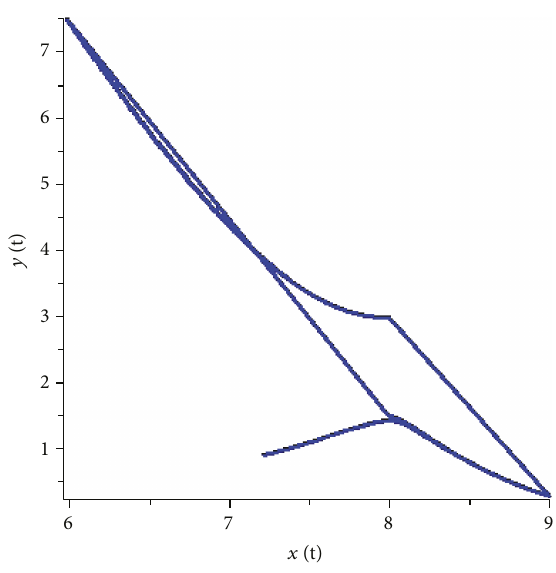
Figure 17: There exists an order-2 periodic solution in system (16) with q 1 = 1/9 , p = 0 8 , and τ = 2 7